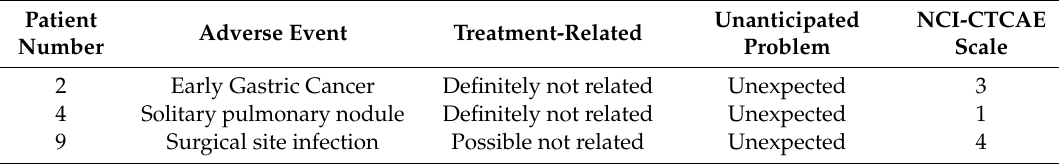
Table 4. Summary of adverse